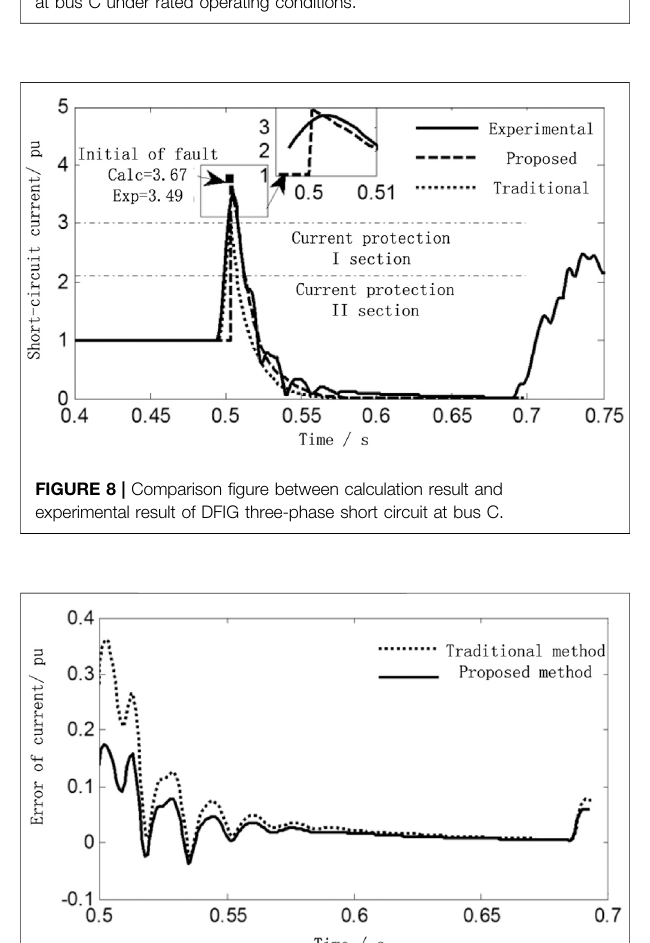
RMS were measured by the experimental platform, and the